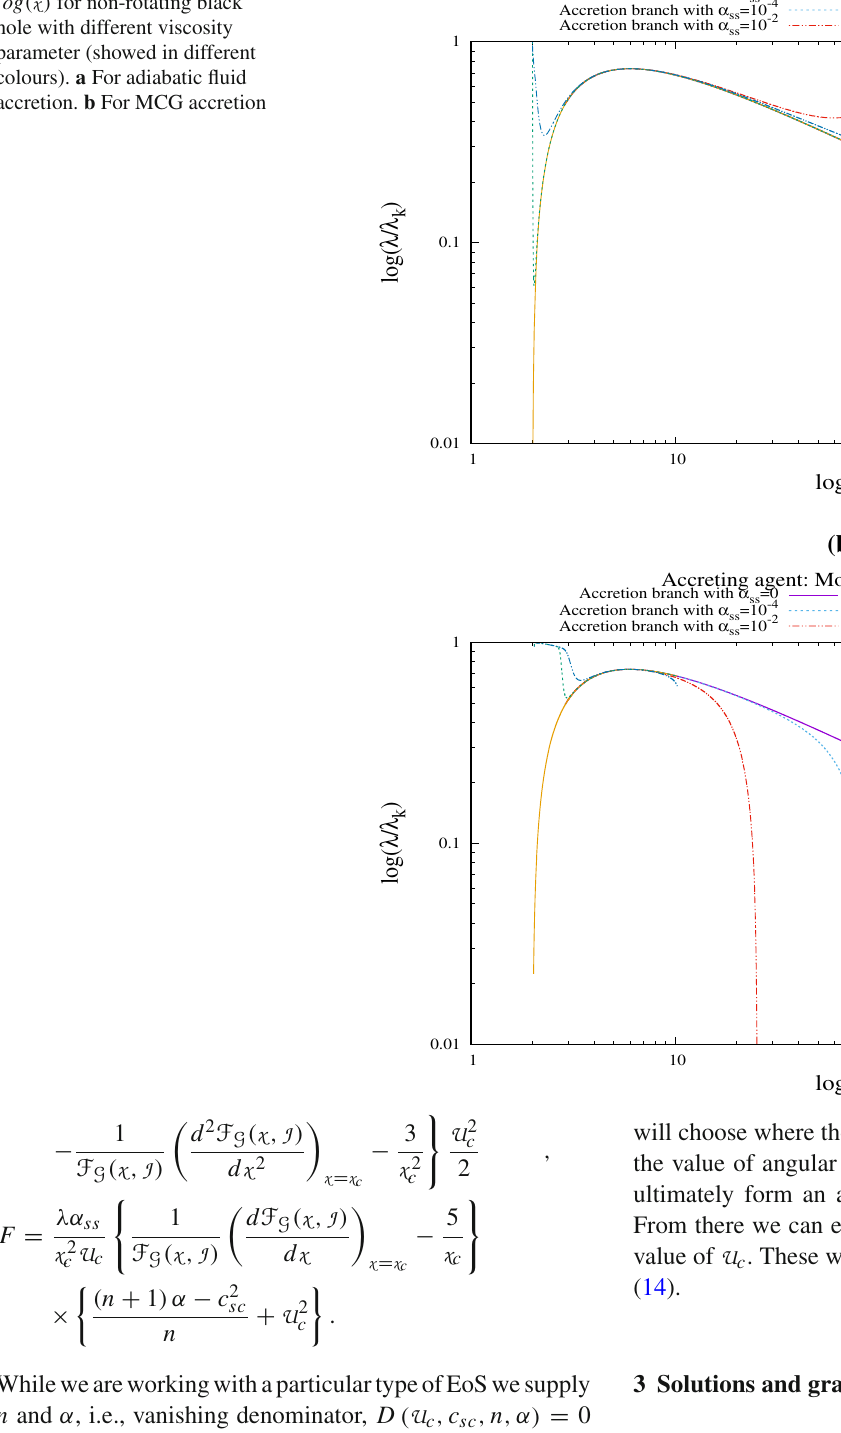
Fig. 4 Plots of accretion and wind branches for log ( λ λ log ( x ) for non-rotating black hole with different viscosity parameter (showed in different colours). a For adiabatic fluid accretion. b For MCG